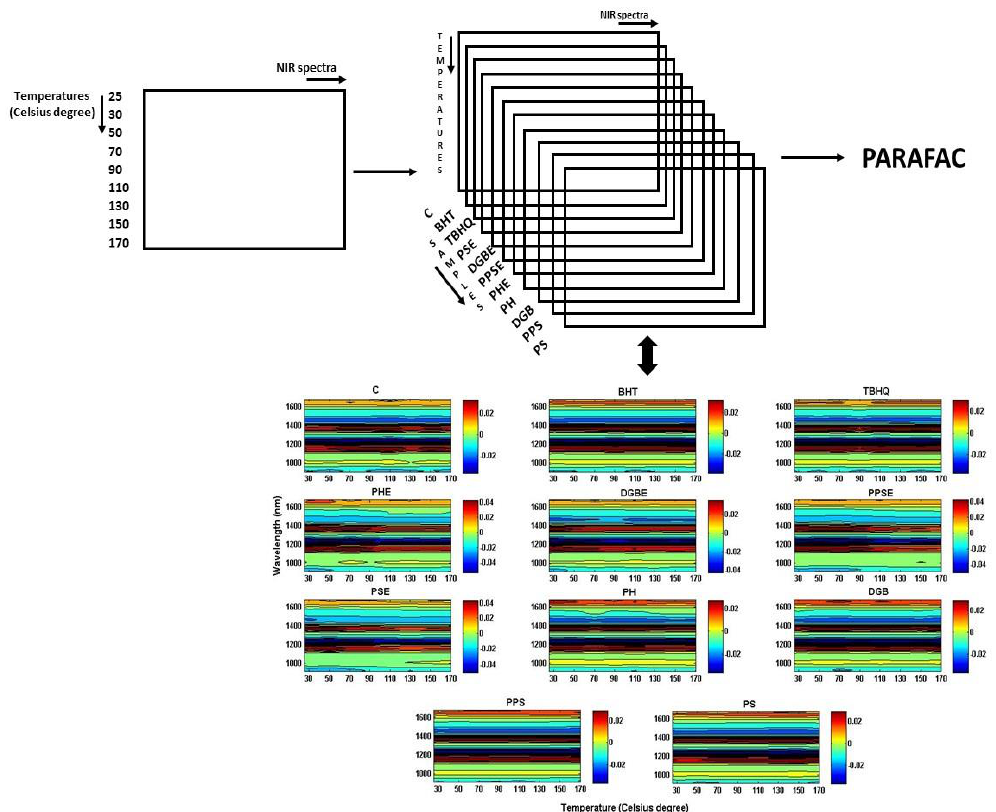
Figure 2. Scheme for illustration of the NIR spectra organization in n-way mode. C = Control (i.e., antioxidant-free soybean oil). BHT = butylated hydroxytoluene. TBHQ = tert-butylhydroquinone. PSE = Poppy seed extract. DGBE = Dehydrated goji berry extract. PPSE = Pumpkin seed extract. PHE = Provençal herbs extract. PH = Provençal herbs. DGB = Dehydrated goji berry. PPS = Pumpkin seed. PS = Poppy seed.